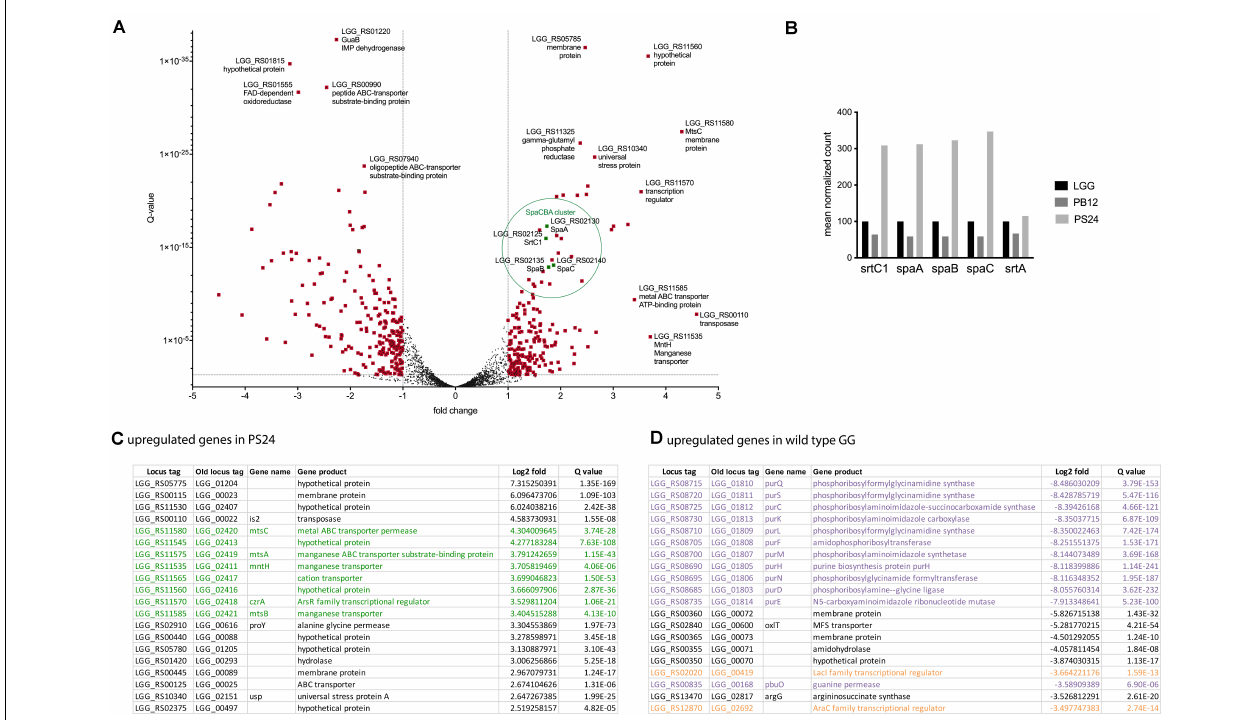
FIGURE 2 | Transcriptomic analysis of PS24 compared to wild-type L. rhamnosus GG at OD 600 nm 2. (A) Volcano plot of differential expression compared for L. rhamnosus GG and PS24. Log2 fold change versus q -value is depicted. Data points marked in red have a log2 fold larger than 1 and a q -value smaller than 0.05. Positive fold change implies higher expression in the PS24 strain. (B) Mean normalized pili transcript count. Normalized expression of the spaCBA-srtC1 gene cluster in the pilus-less PB12 derivative and PS24 derivative relative to wild-type L. rhamnosus GG. The housekeeping sortase A was included for comparison. (C) Top 20 upregulated genes in PS24 derivative. The top 20 genes with the highest log2fold value compared to wild-type L. rhamnosus GG at OD 600 nm 2. (D) Top 20 downregulated genes in PS24 derivative. The top 20 genes with the highest log2fold value in wild-type L. rhamnosus GG at OD 600 nm 2, compared to the PS24